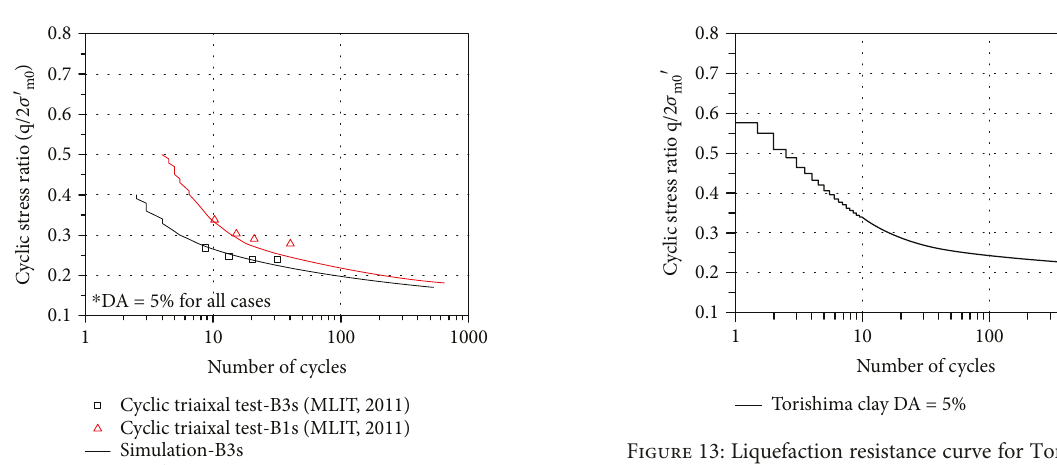
Figure 11: Finite element mesh and boundary conditions.